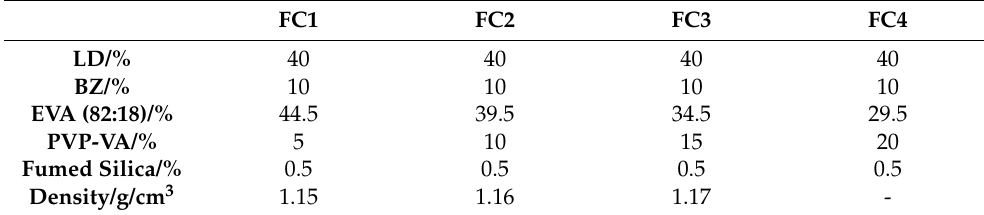
Table 6. Formulation development of LD/BZ fixed combination (FC) formulation.